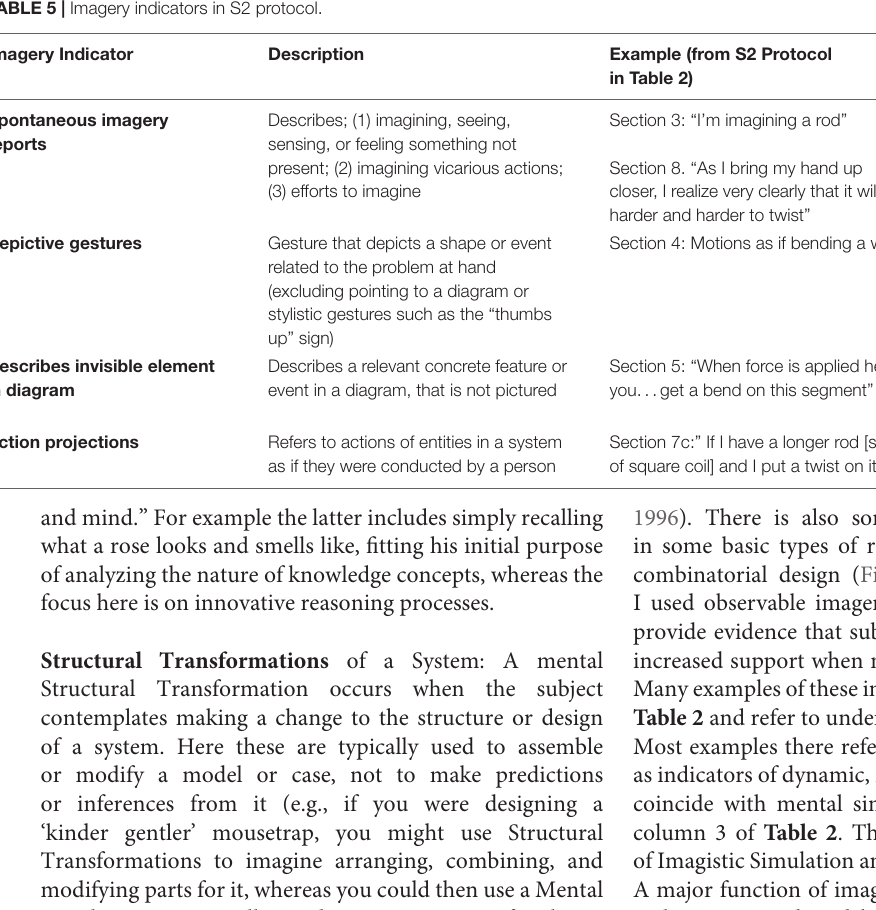
TABLE 5 | Imagery indicators in S2